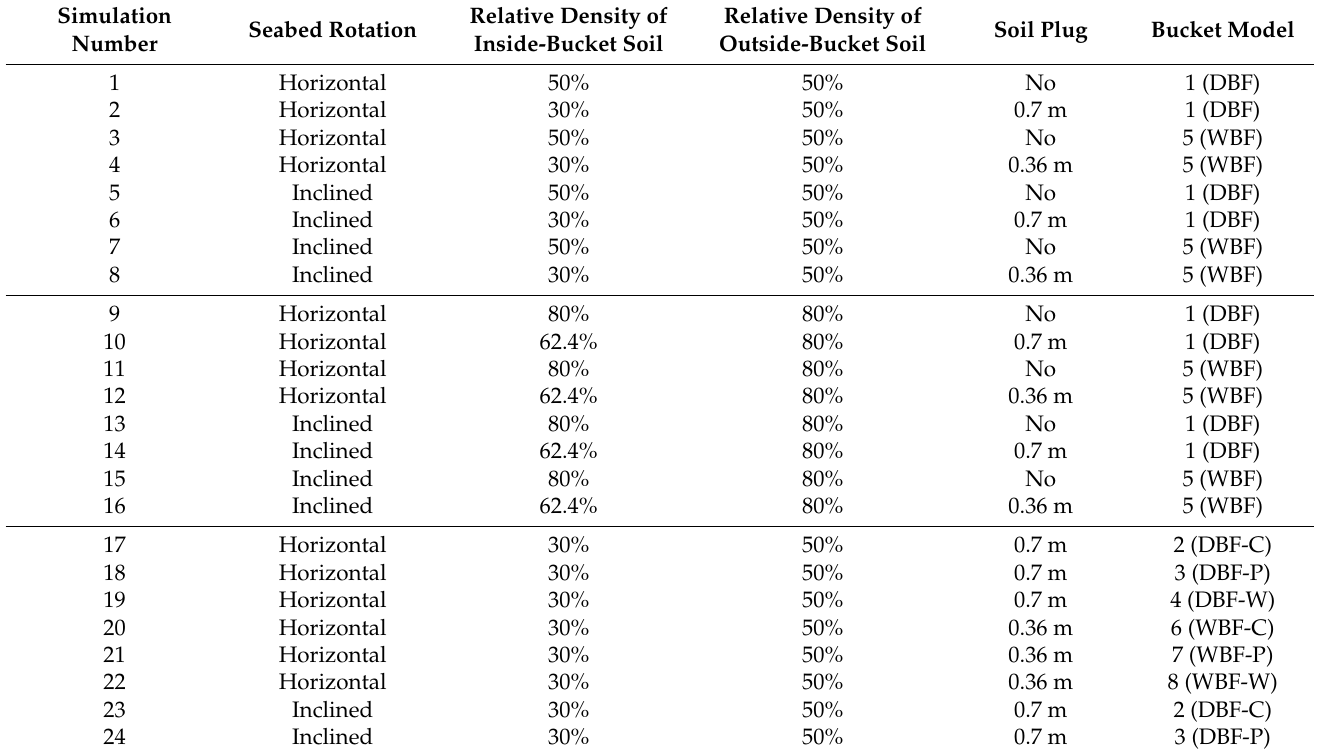
Table 4. Numerical simulations conducted in this